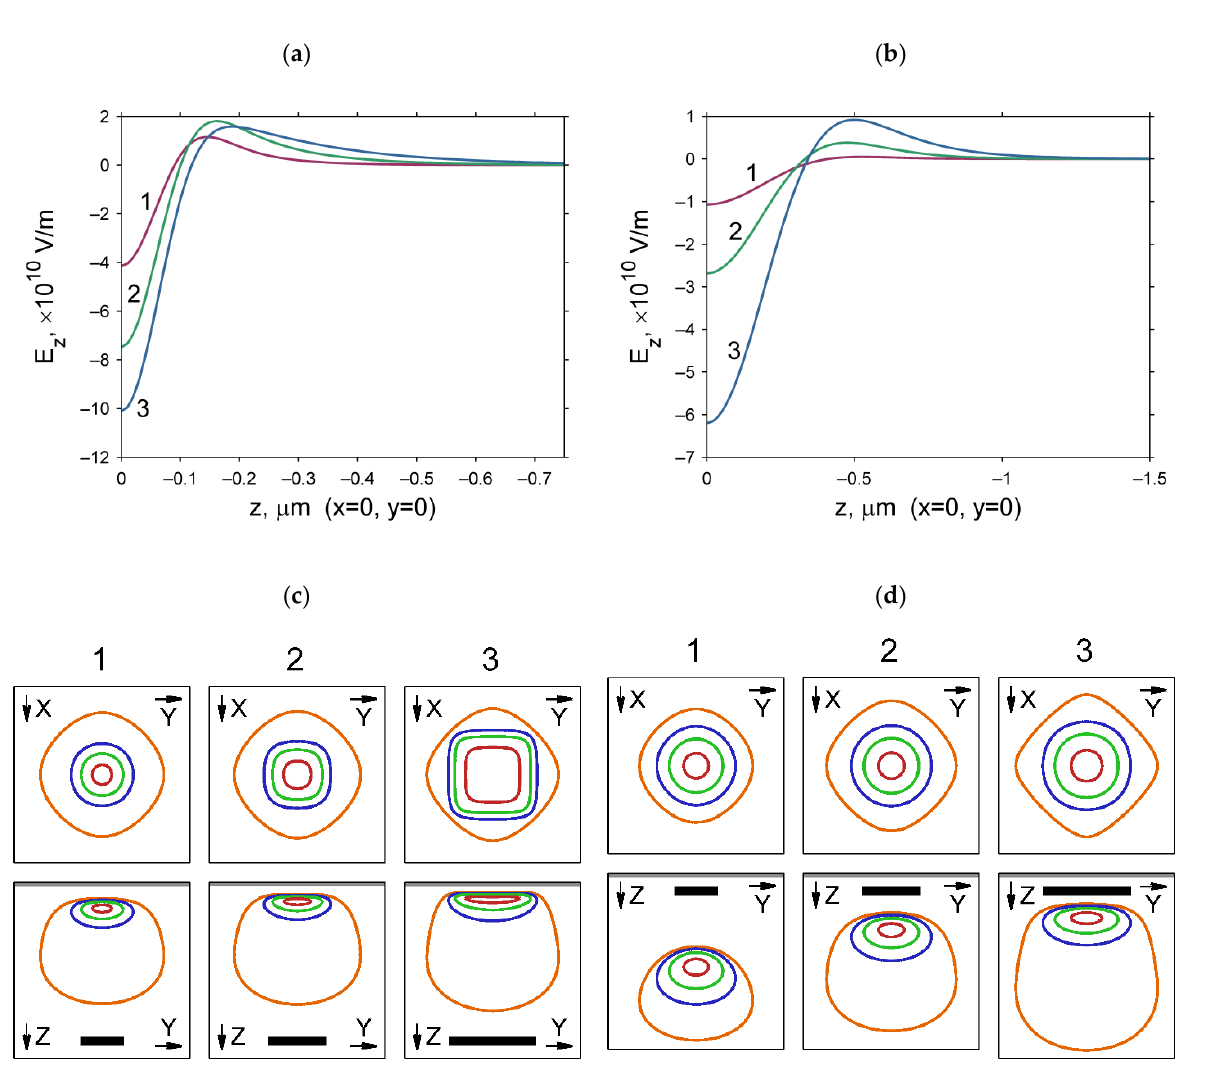
max E , 0.6 max E , 0.3 max E , z z z